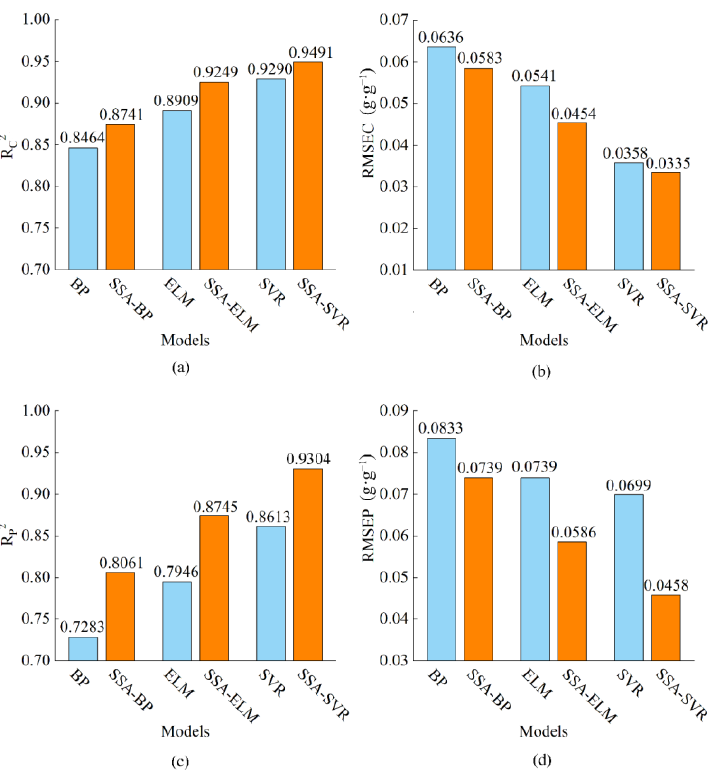
Figure 5. Comparison of R 2 and RMSE for different models in each dataset. ( a , b ) Calibration set (10-fold cross-validation); ( c , d ) prediction set. R C2 : coefficient of determination in calibration set; R P2 : coefficient of determination in prediction set; RMSEC: root mean squared error for calibration set; RMSEP: root mean squared error for prediction set.